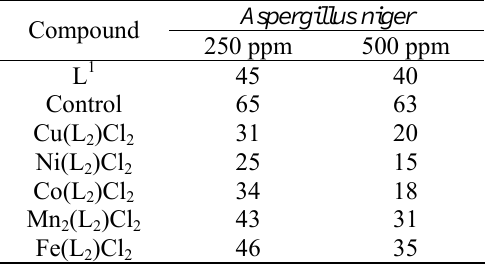
Table 6. Antifungal activities of ligand and their metal complexes by mycelial dry weight (MDW) at 250 and 500